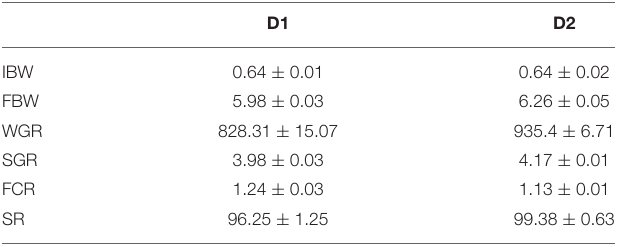
TABLE 4 | Growth performance and feed utilization of Litopenaeus vannamei fed diets supplemented with/without Klebsormidium sp. for 56 days.